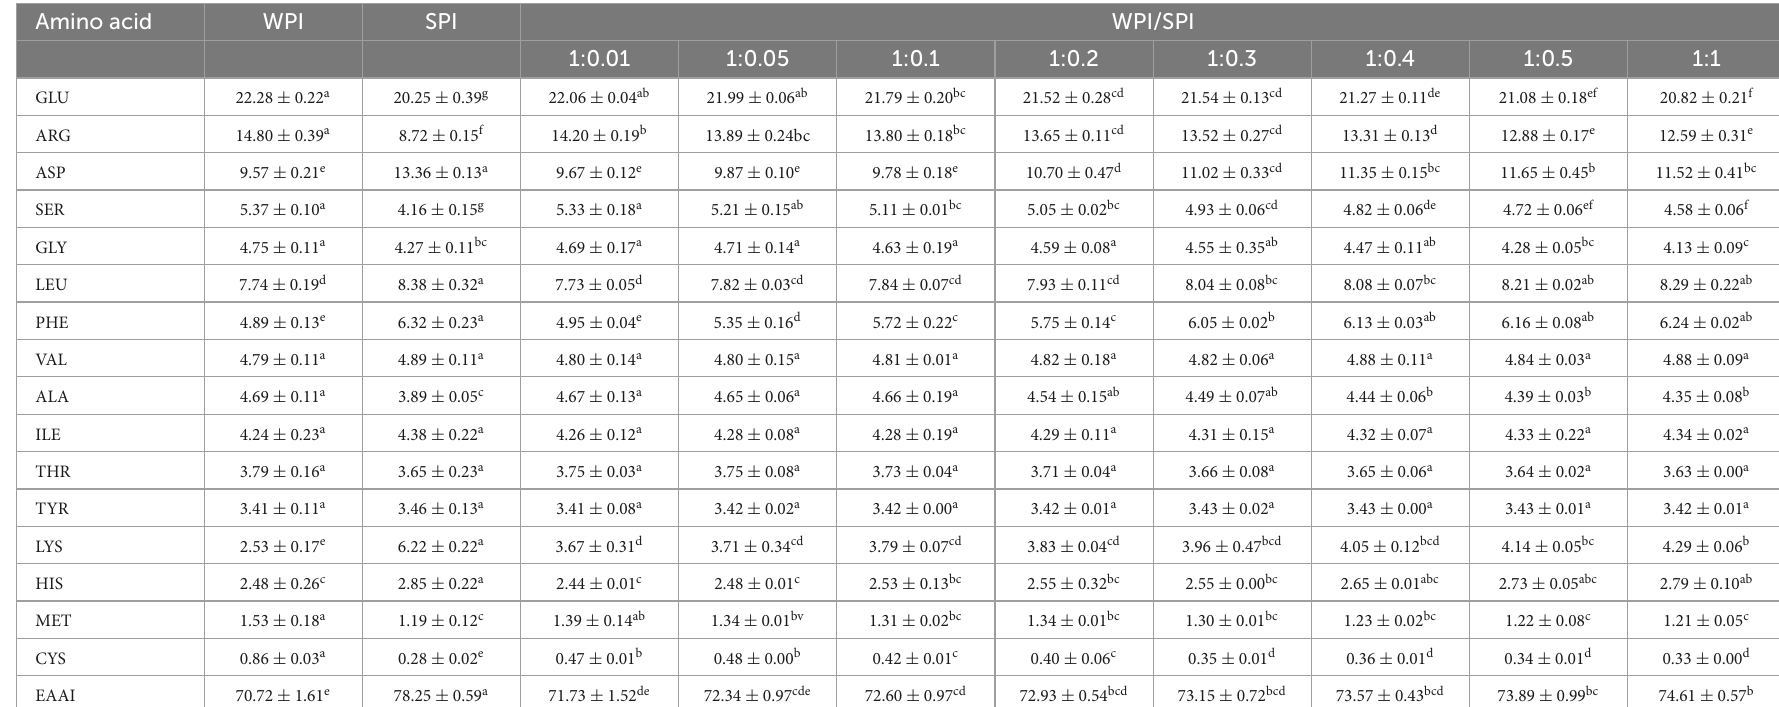
TABLE 1 Amino acid composition of WPI-SPI